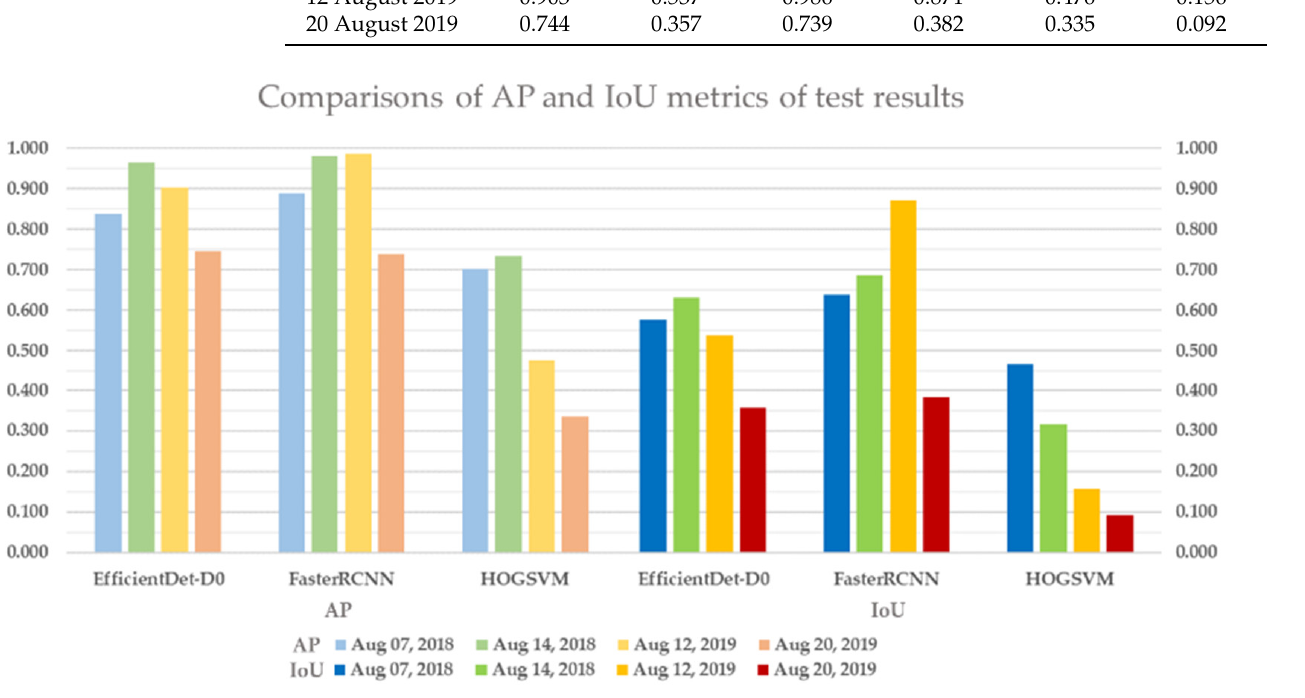
Table 7. Evaluation of AP and IoU on four datasets. EfficientDet Faster R-CNN Model